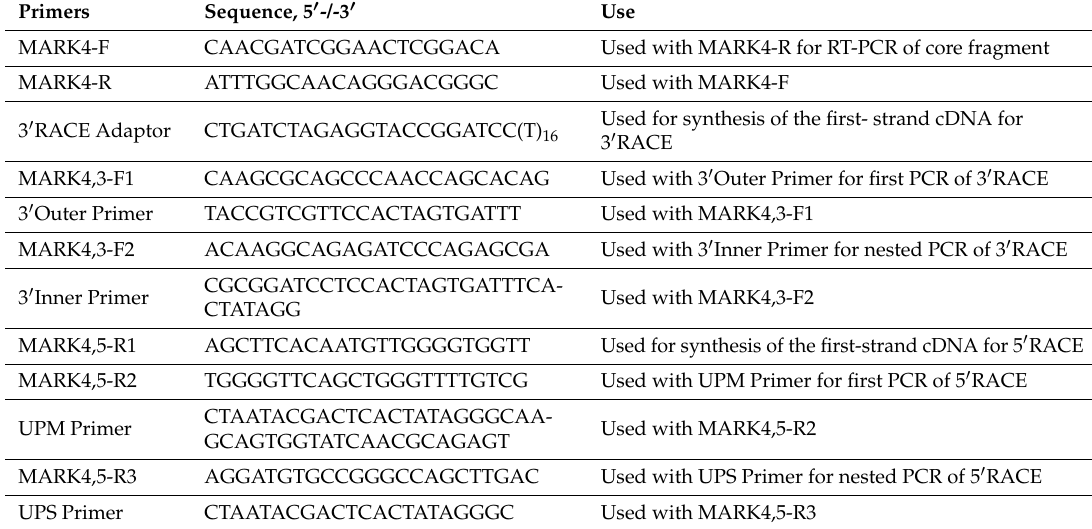
Table 1. Primers for the cDNA cloning of MARK4